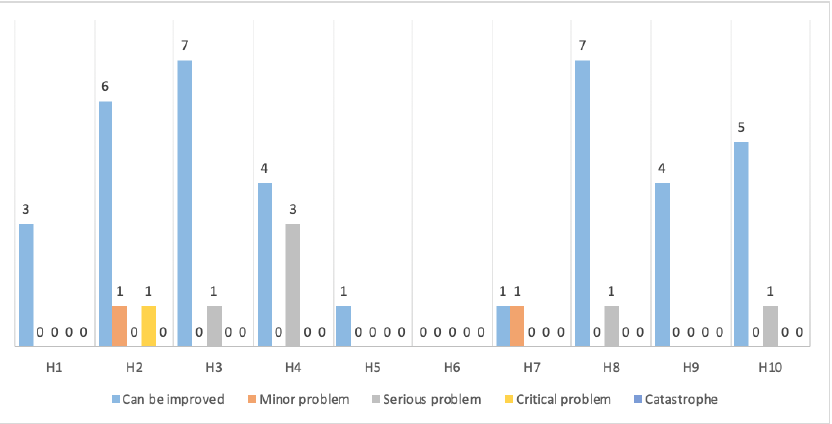
Figure 3. Problems identified in each heuristic classified according to their degree of severity.